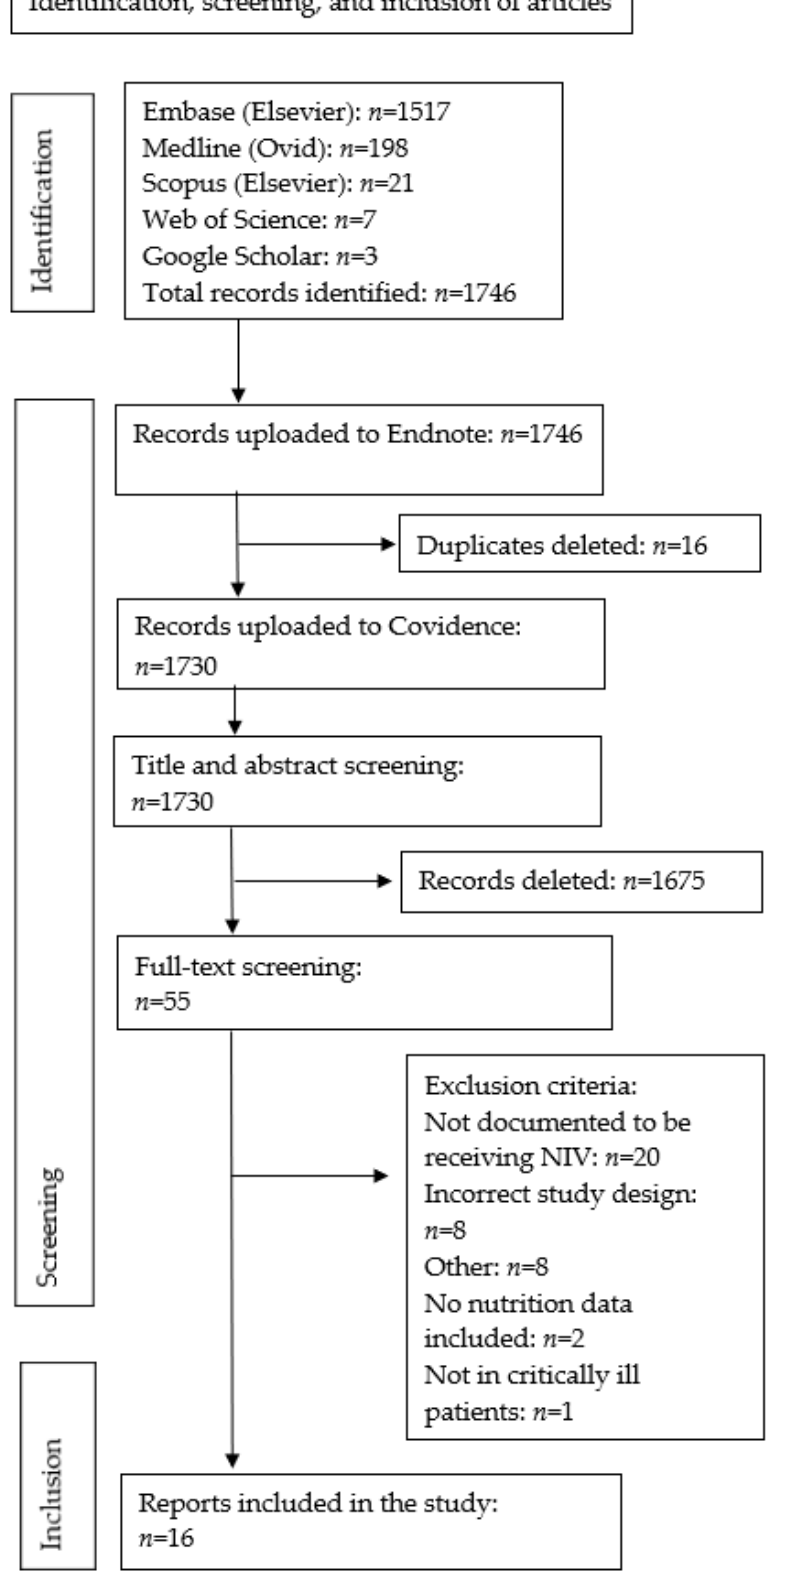
Figure 1. Flow chart for the identification, screening and inclusion of studies.